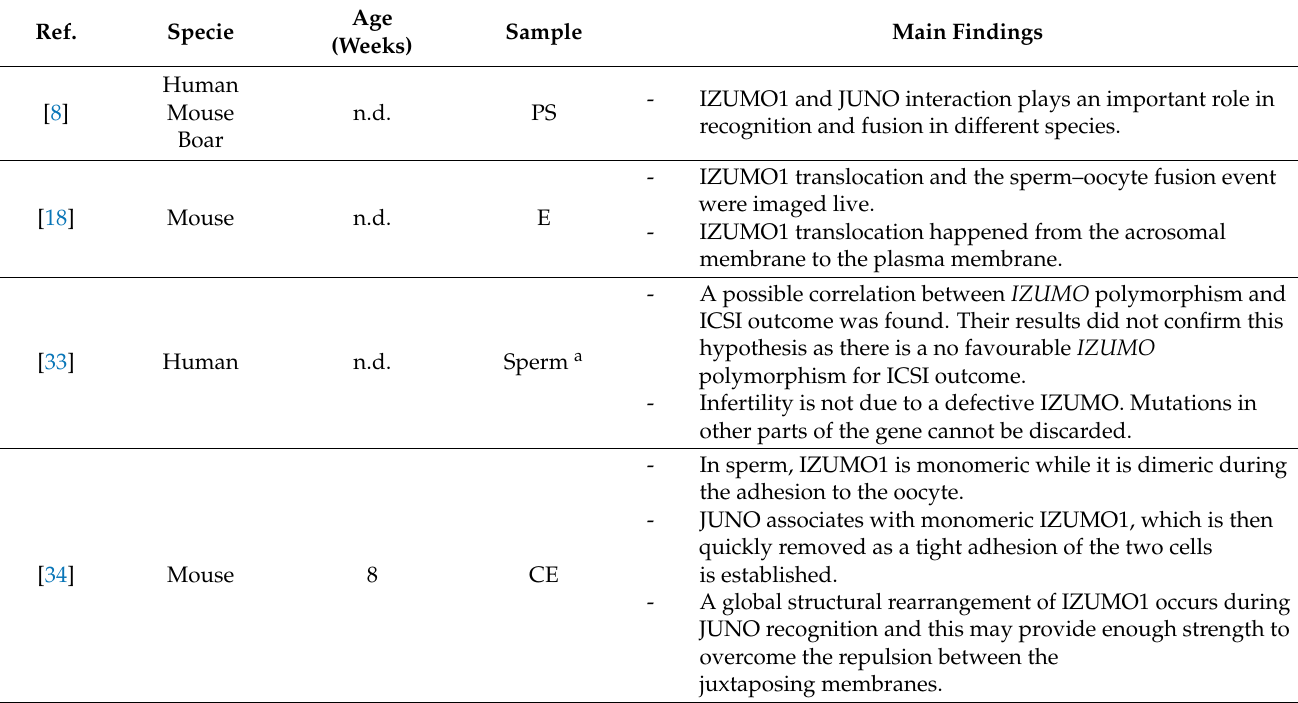
Table 4. Articles studying IZUMO1